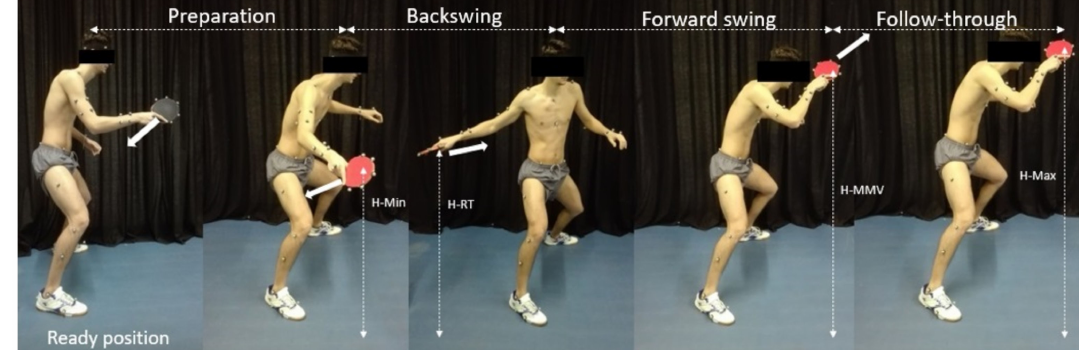
Figure 3. The movement sequence of the table tennis top spin forehand including measured variables (H-Min, H-RT, H-MM, and H-Max) and different phases (preparation, backswing, forward swing, and